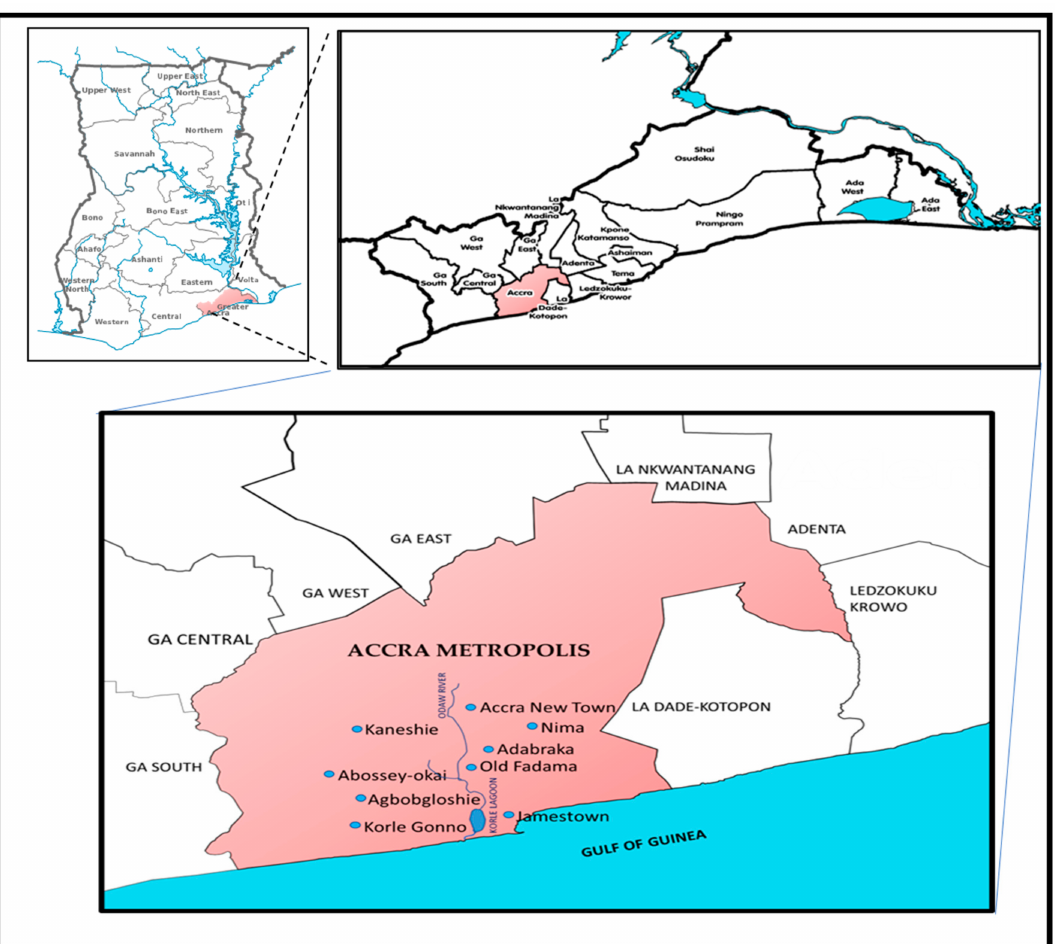
Figure 4. Map of Accra Metropolis showing study